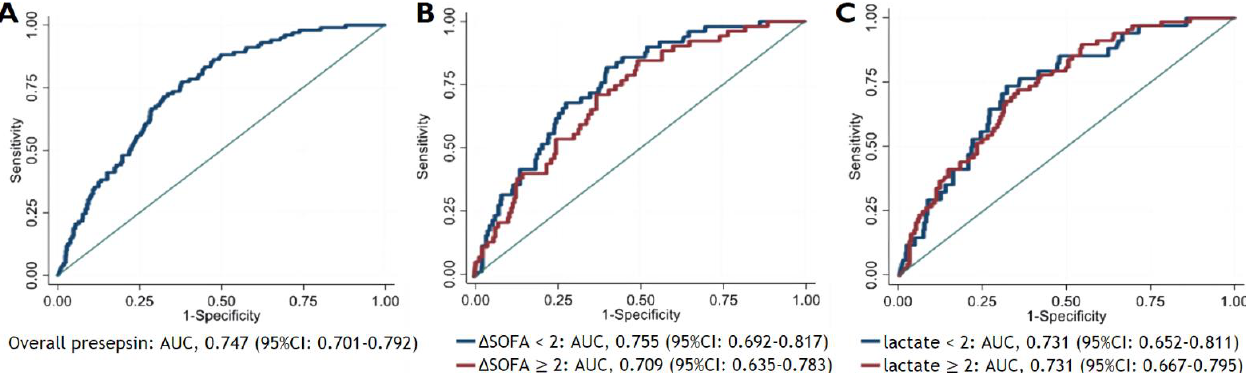
Figure 4. Area Under the Curve (AUC) of the Receiver Operating Characteristic (ROC) Curves of presepsin for predicting 28-day mortality according to the delta SOFA score and the lactate level in the following groups: ( A ) overall study population, ( B ) subgroups according to the delta SOFA (<2 or ≥2), and ( C ) subgroups according to the lactate levels (<2 mmol/L or ≥2 mmol/L).